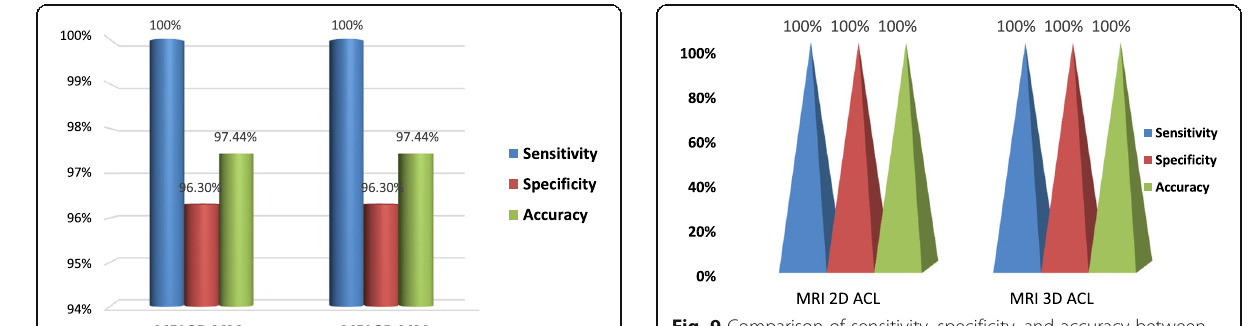
Fig. 9 Comparison of sensitivity, specificity, and accuracy between 2D VS 3D in detecting ACL